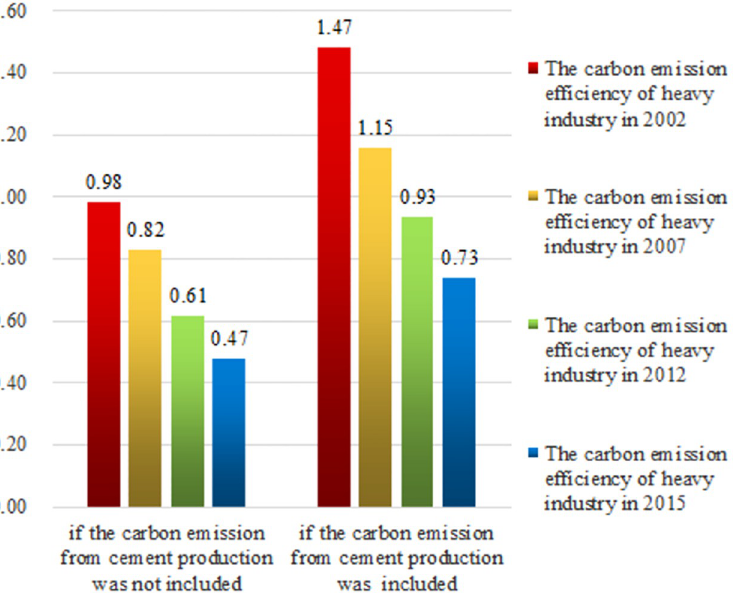
Fig 2. The carbon emissions efficiency in heavy